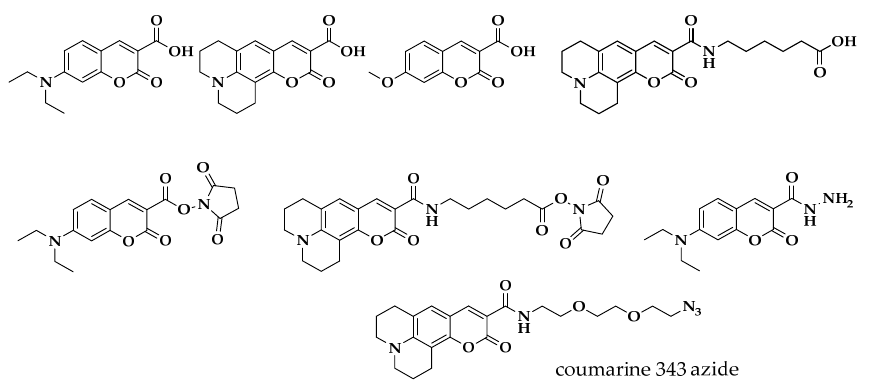
Figure 1. Some commercially available fluorescent coumarins.